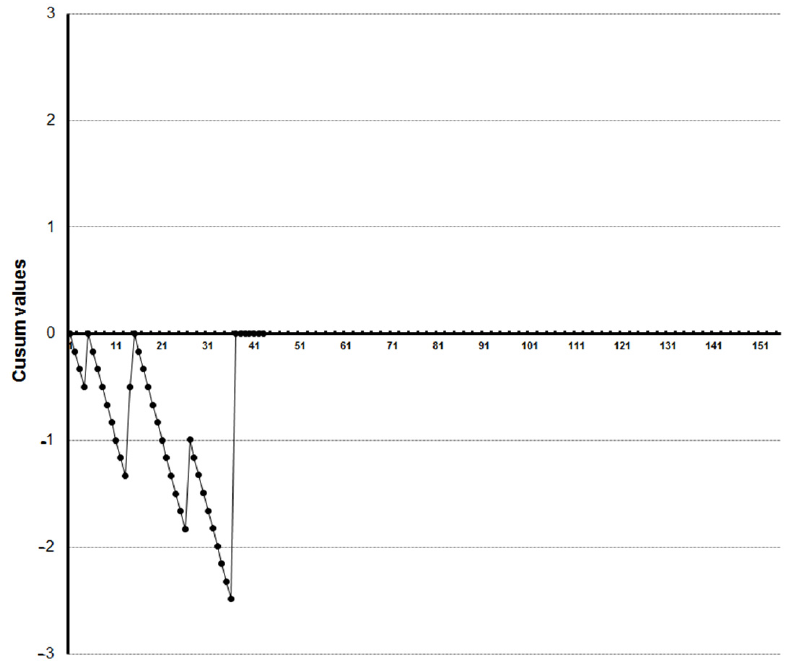
Figure 7. LC-CUSUM curve for trainee three.